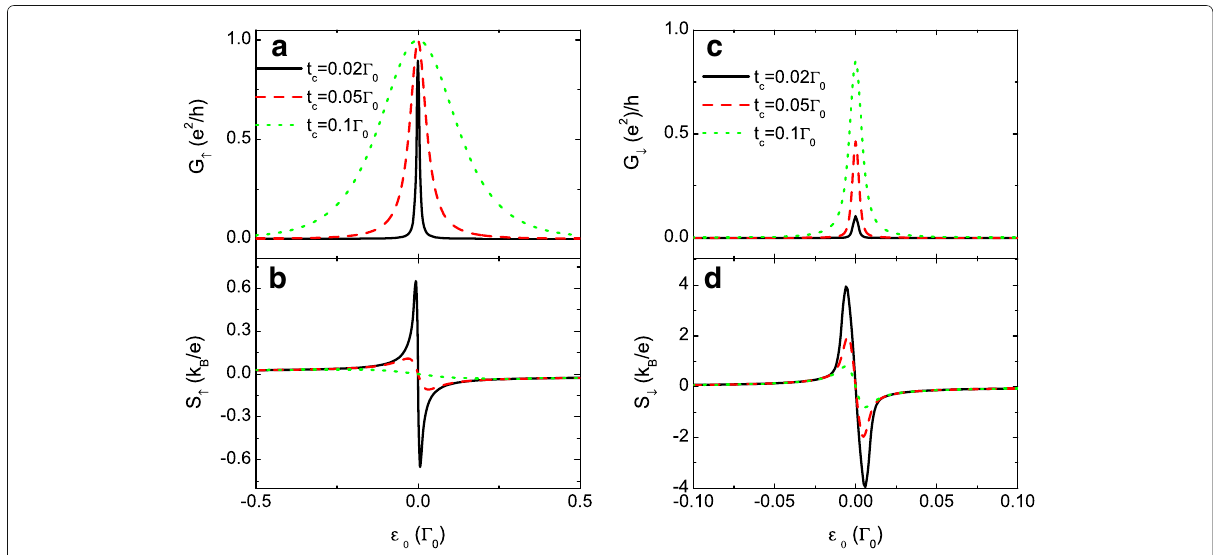
Fig. 4 Conductance and the thermopower for different t c . Spin-polarized conductance G σ in a and c , and the thermopower S σ in b and d as functions of the dot level ε 0 for p = 0.7 and different values of t c . The other parameters are as in Fig. 2